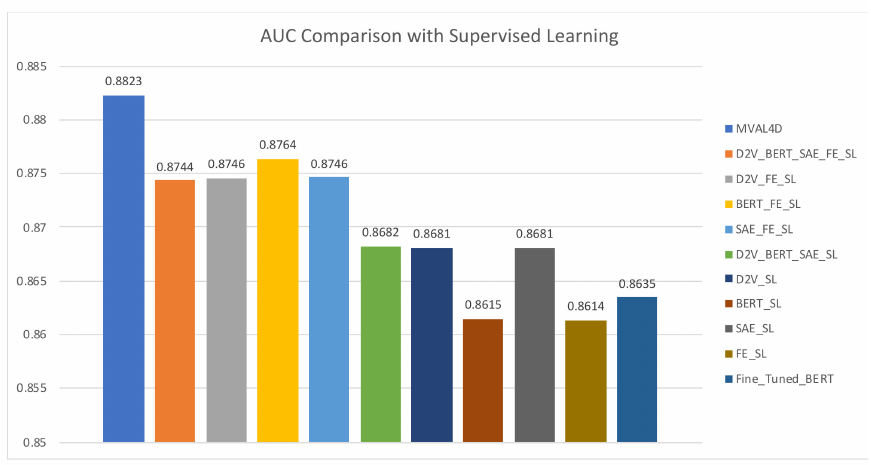
Figure 10. AUC comparison with supervised